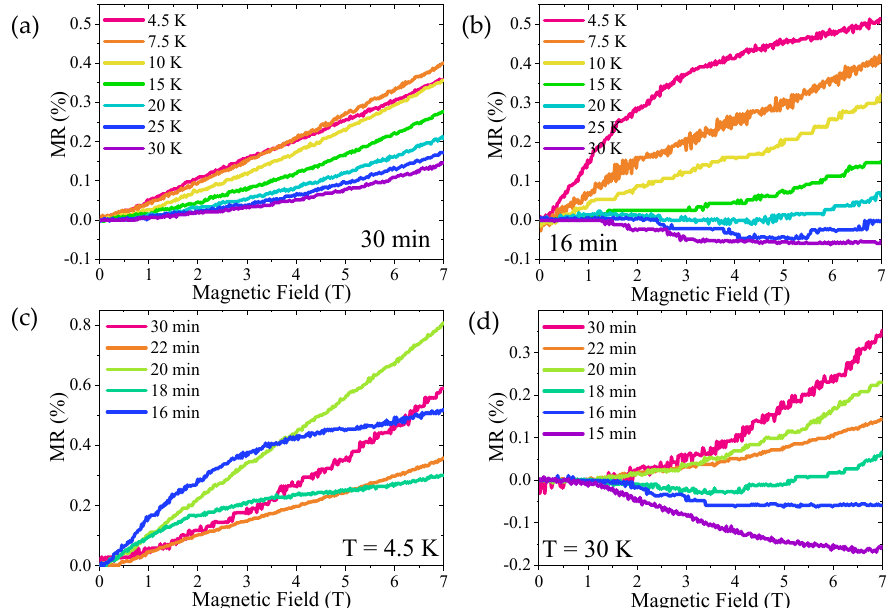
Figure 4. Magnetoresistance at different temperatures of a thick ( a ) and a thin ( b ) VTe 2 film. A transition from positive to negative MR is observed for the thin sample above 15 K. Magnetoresistance for different VTe 2 film thicknesses at 4.5 K ( c ) and 30 K ( d ).